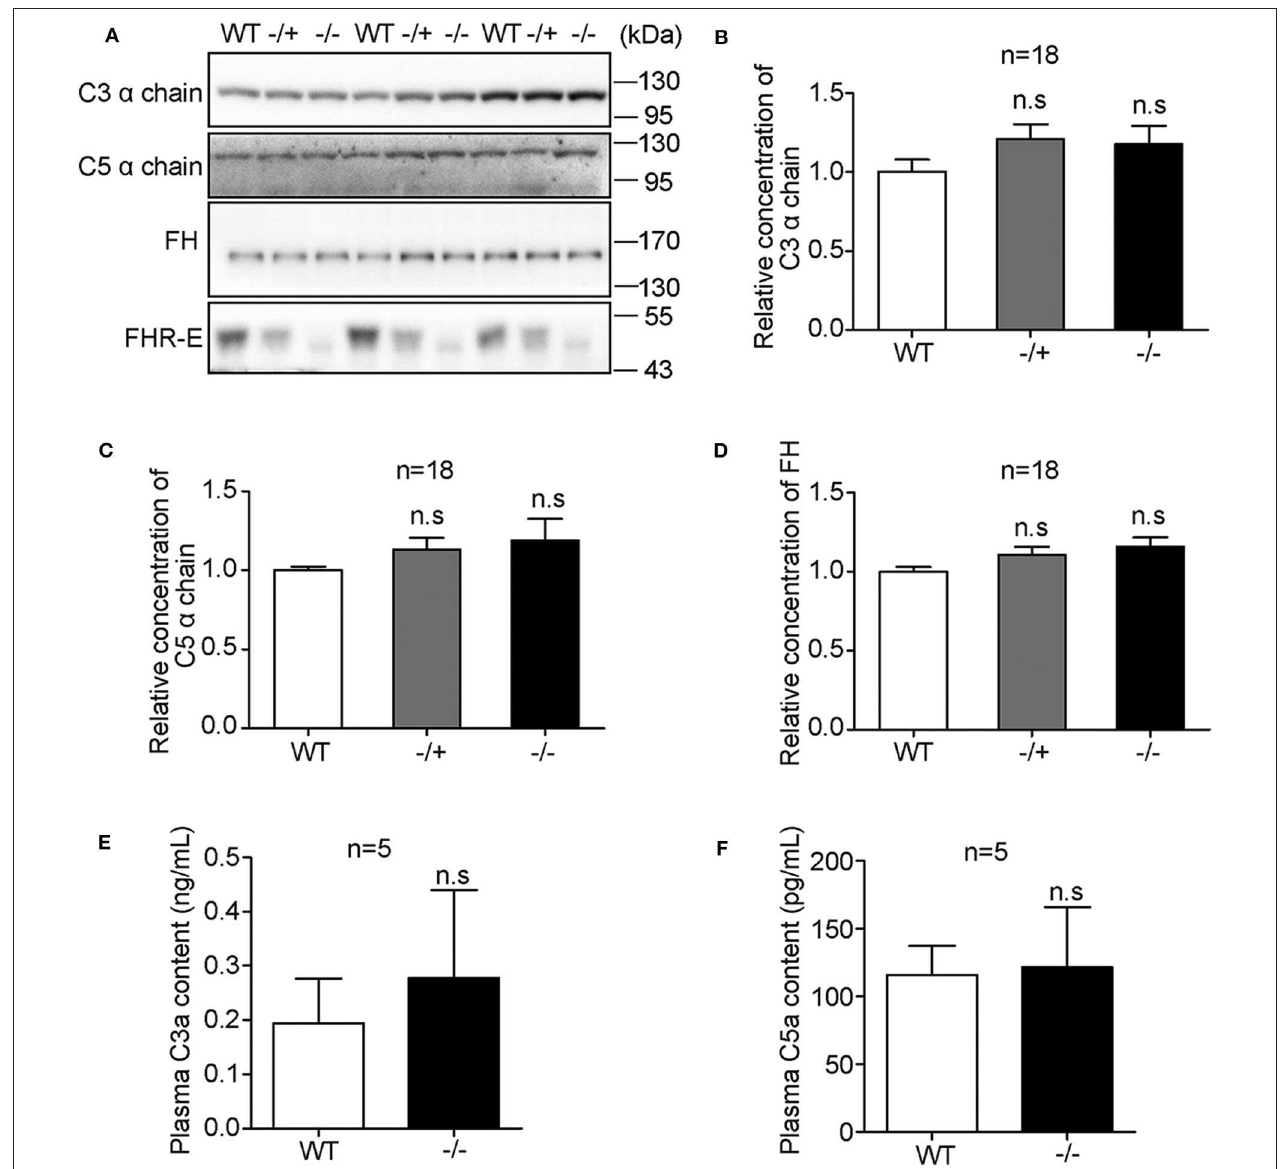
FIGURE 3 | Detection of plasma levels of major complement factors among mice of different genotypes under physiological conditions. (A) Representative Western blotting analyses of plasma C3, C5, FH, and FHR-E. Equal volume of plasma was loaded. Eighteen mice in each group were included. (B–D) The gray values of C3, C5, and FH were measured with Image J. The calculated gray values of each blot were divided by the average gray value of wild type in the blot. (E,F) Measurements of plasma concentration of C3a and C5a with ELISA kit. EDTA anti-coagulant blood was obtained from heart puncture. Five mice in each group were used. Very low background absorption was detected in different genotype mice. n.s., not